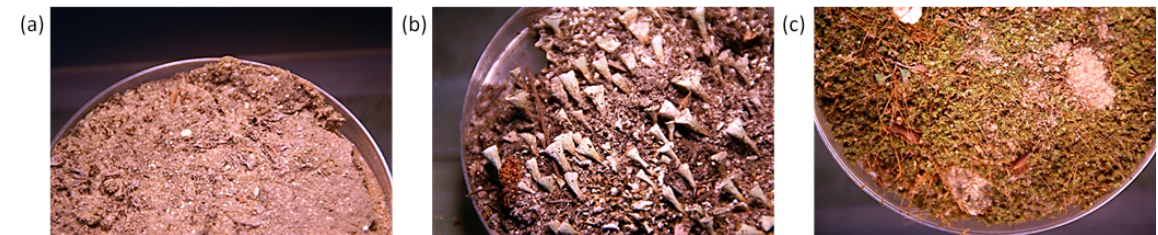
Figure 1. Natural biocrusts at different levels of development: (a) a cyanobacterial biocrust, (b) a lichen crust, and (c) a moss crust. Samples were collected in Mata Nacional da Machada, Lisboa. Picture and graphic elaboration by Alessandra